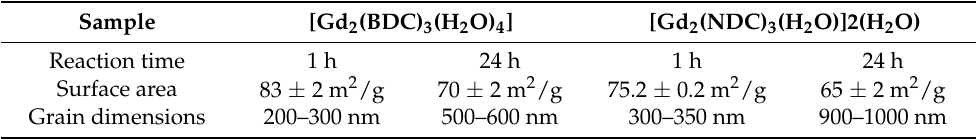
Table 1. Surface area and grain dimensions of the 1 h and 24 h Gd-MOF samples with BDC and NDC